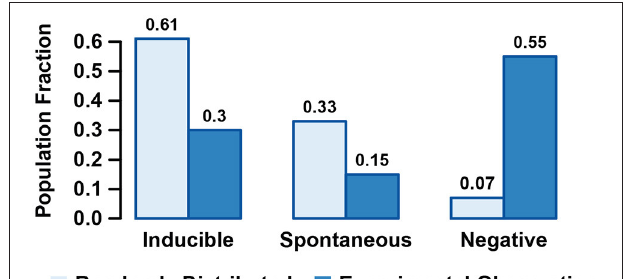
FIGURE 5 | Fraction of states randomly selected based on an equiprobable random distribution that are contained in the basins of attraction of Inducible, Spontaneous, and Negative attractors and comparison with the experimental observed fraction of sperms displaying induced, Spontaneous, or Negative acrosome reaction (AR).